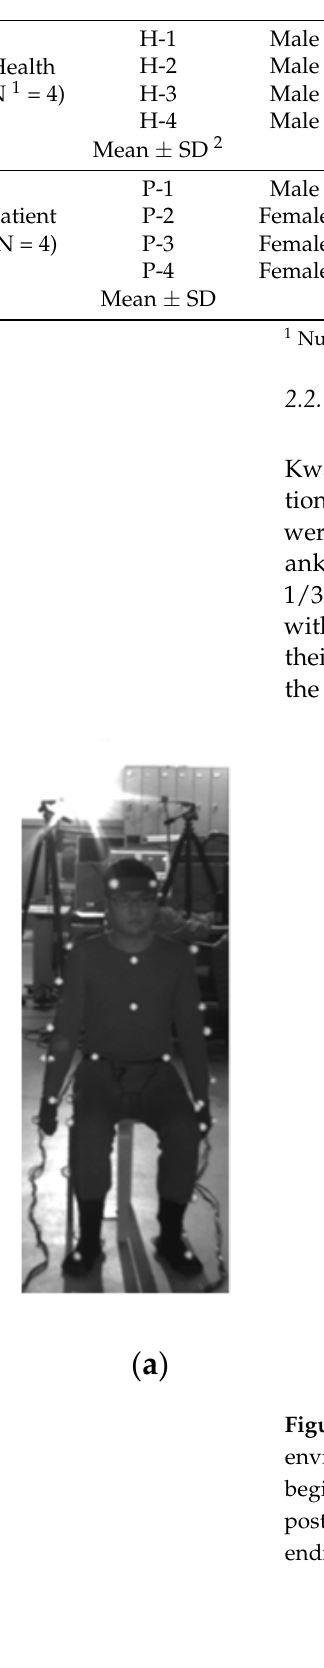
Figure 2. Experimental setup. A calibration space (150 cm × 150 cm × 195 cm) photographed with four CCD cameras.